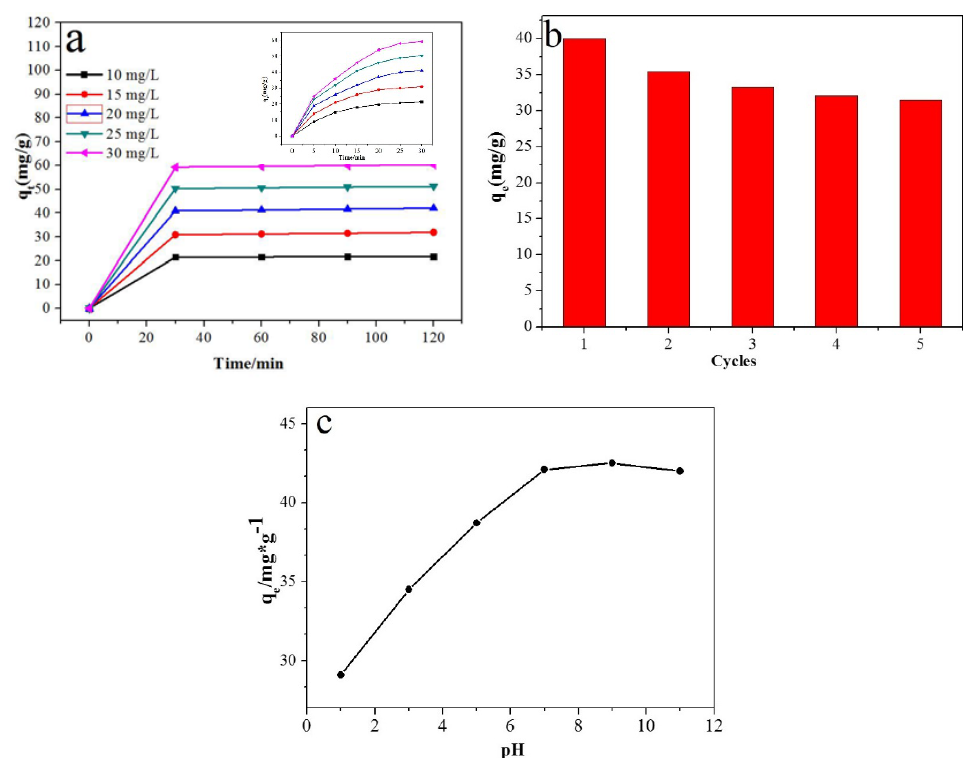
Figure 10. ( a ) The adsorption on methylene blue (MB) solution with different initial concentrations (the time range of the inset is 0–30min), ( b ) adsorption capacity of MB on ITO-rGO and TiO 2 in five successive cycles, and ( c ) effect of pH value on sample adsorption.